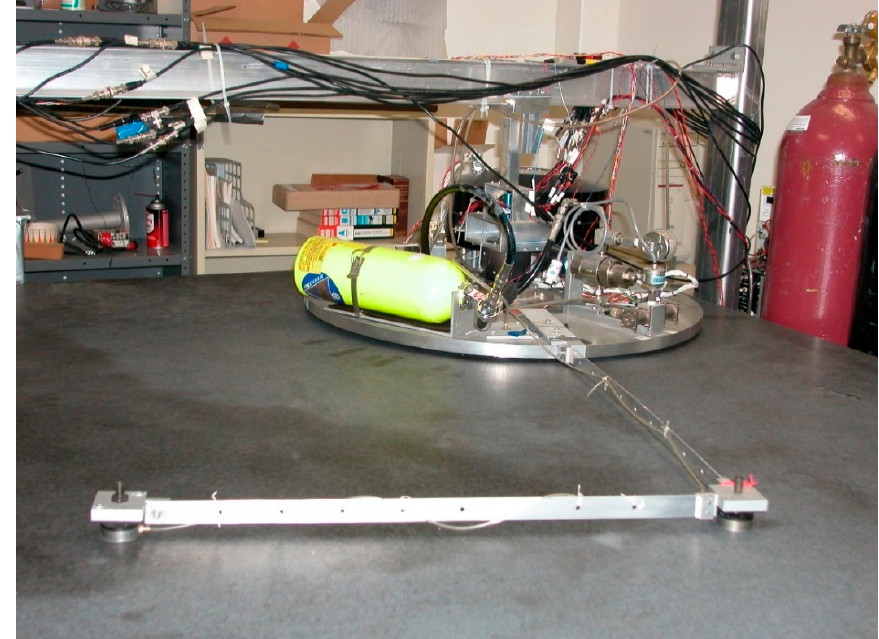
Figure 1. Flexible spacecraft robotic arm (very lightweight) attached to a rotational hub free-floating on planar air-bearing. The flexible arm is modeled using the lumped-mass technique where arm mass is distributed to discretized nodes as depicted in Figure 2.